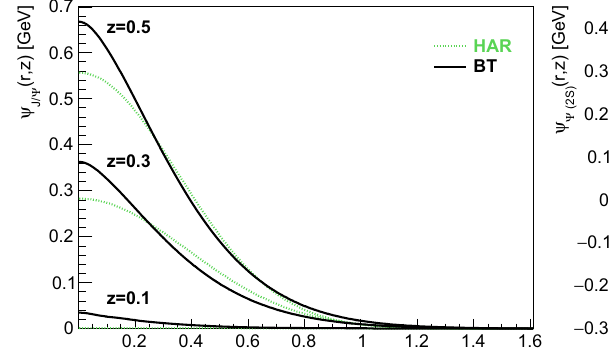
the c − ¯ c interaction potential: harmonic oscillator model denoted as HAR (green dotted lines) and Buchmüller-Tye parameterisation, or BT (black solid lines)